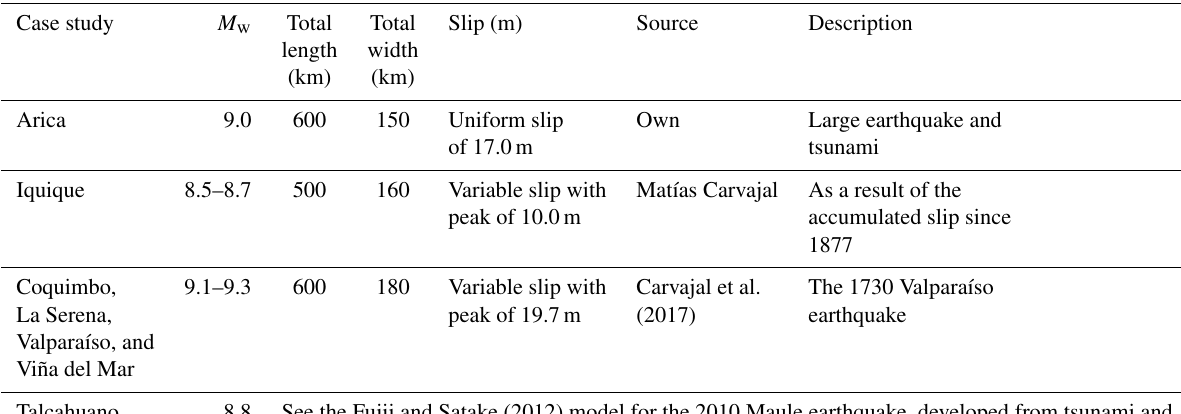
Table 2. Seismic parameters of the examined case studies.